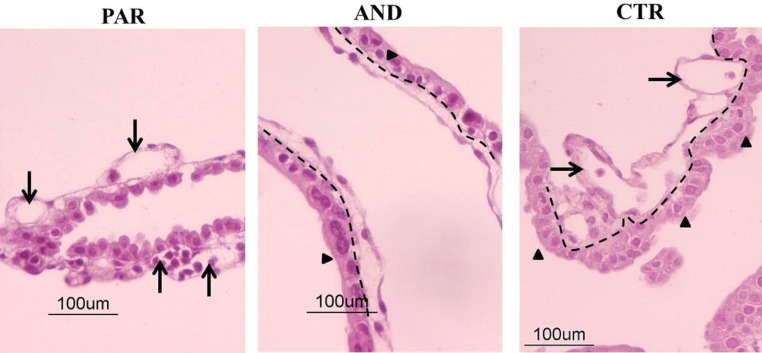
General and vascular morphology is defective in uniparental placentae (chorion-allantoid tissues) at day 20 of pregnancy.Hematoxylin & Eosin staining of uniparental (AND, PAR) chorion-allantoid tissues showed defective general morphology and vasculogenesis compared to biparental CTR, in agreement with our preliminary observations [22]. There was a well-organized trophoectodermal epithelium (arrowhead) and a well-defined basement membrane (dashed line) between chorion and allantoid in AND but not in PAR tissues. The presence of a vascular network (arrows) was observed in the PAR allantoid but not in AND.